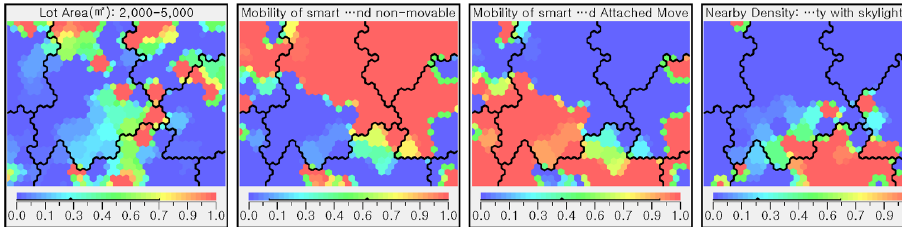
Figure 2. Part of the result of Plane Map.